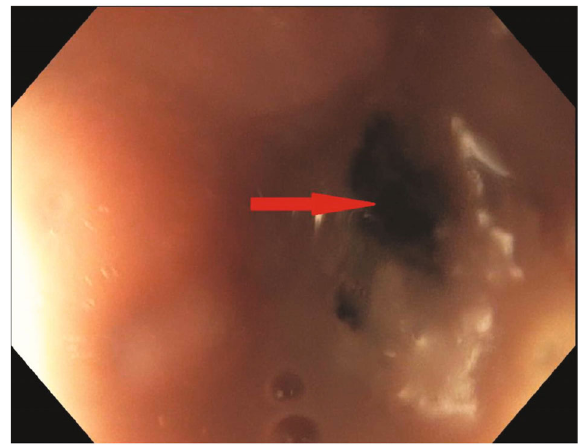
Figure 3: Endoscopic view of the distal esophageal perforation was identi fi ed at 31cm (red arrow).